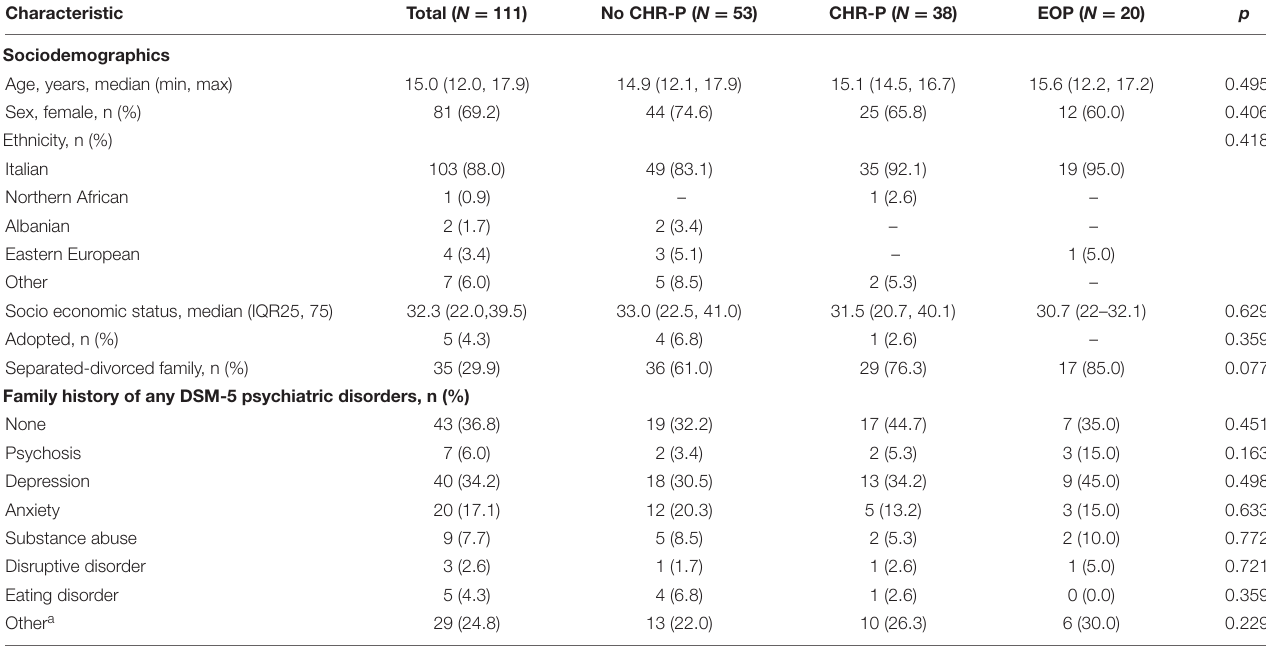
TABLE 1 | Sociodemographics and family history of psychiatric disorders in the total adolescent sample and the clinical high risk state for psychosis (CHR-P), no CHR-P, and early onset psychosis (EOP) subgroups. Characteristic Total ( N = 111) No CHR-P ( N =